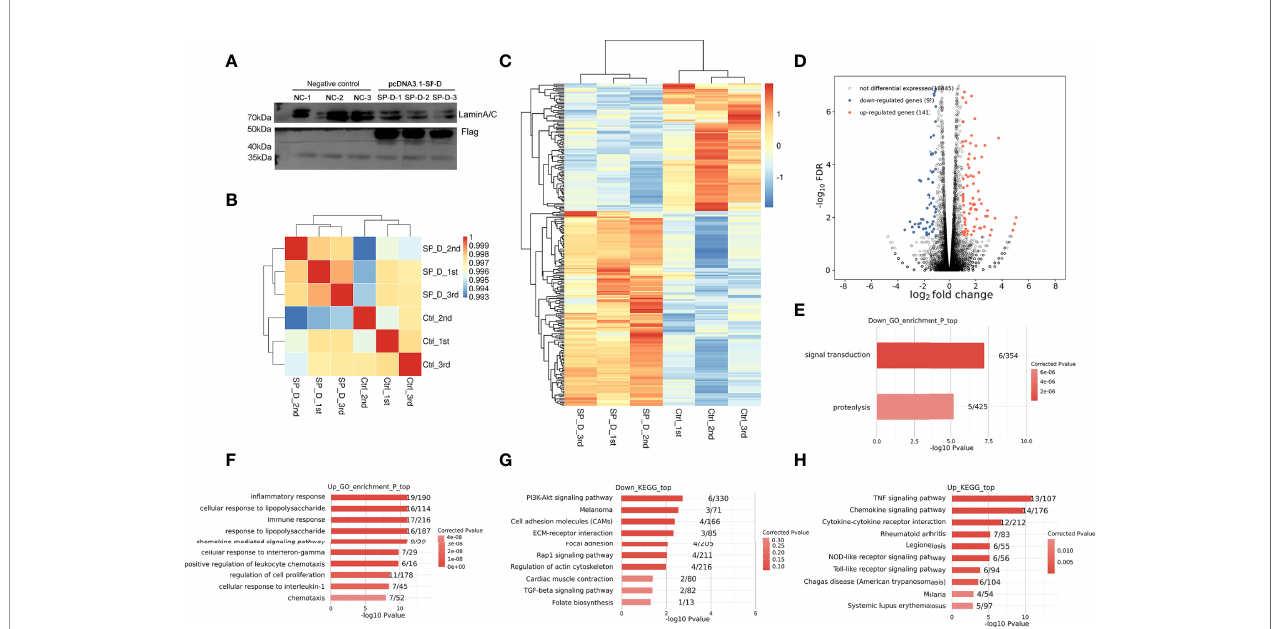
FIGURE 1 | Effects of SP-D overexpression on the gene expression pro fi le of chondrocytes. (A) Chondrocytes were co-treated by lipofectamine transfected pcDNA3.1 empty plasmid and pcDNA3.1-SP-D plasmid (1 m g/ m L). The protein expression of SP-D was assessed via western blotting. (B) The clustering analysis of samples showed high similarity, which con fi rmed the correctness of the experimental design and sample sampling. (C) The heat map showed that the gene expression patterns and clustering relationships of the samples were similar. (D) Comparisons between samples showed the number of differentially expressed genes. (E, F) GO analysis showed that the biological processes such as regulation of ‘ in fl ammatory responses ’ , ‘ immune response ’ and ‘ response to LPS ’ were associated with SP-D in chondrocytes. (G, H) KEGG pathway analyses revealed these genes to be signi fi cantly linked to pathways including the ‘ PI3K-Akt signaling pathway ’ , ‘ ECM-receptor interaction ’ , ‘ TLR signaling pathway ’ , and ‘ TNF signaling pathway ’